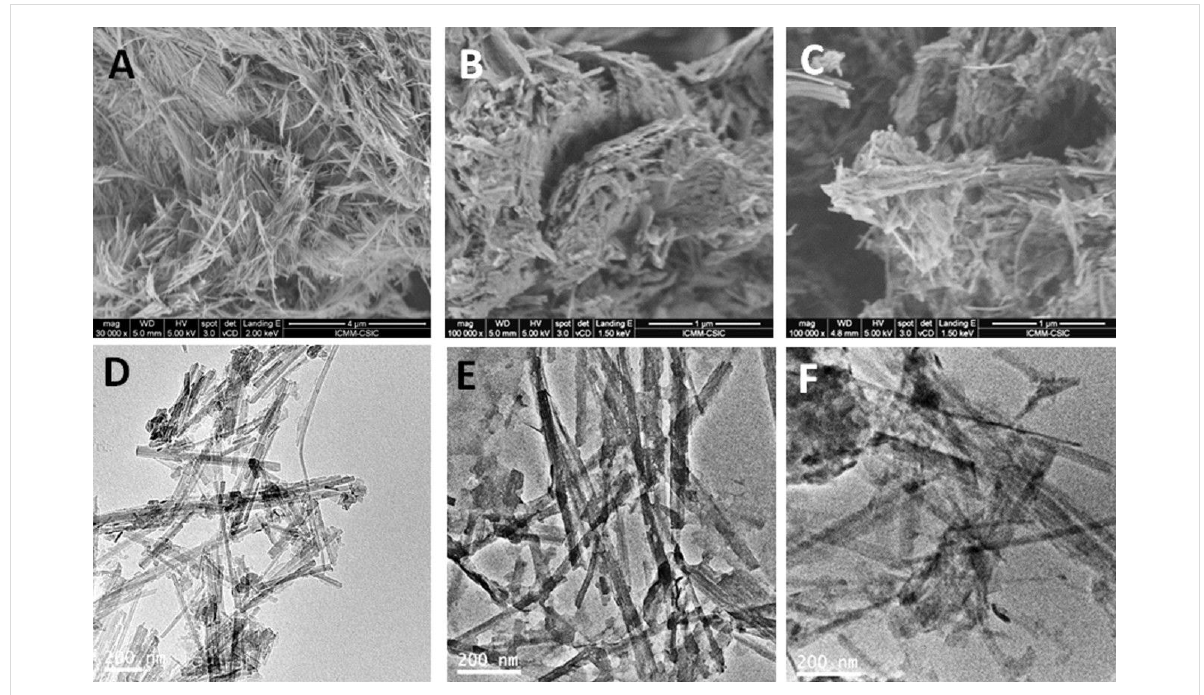
Figure 3: FE-SEM images of (A) sepiolite, (B) LDH/Sep1:1_150C and (C) MCPA ie -LDH/Sep1:1_150C nanoarchitectures; TEM images of (D) LDH/Sep0.5:1_150C, and the LDH/Sep1:1_150C nanoarchitecture (E) before and (F) after the ion exchange treatment with